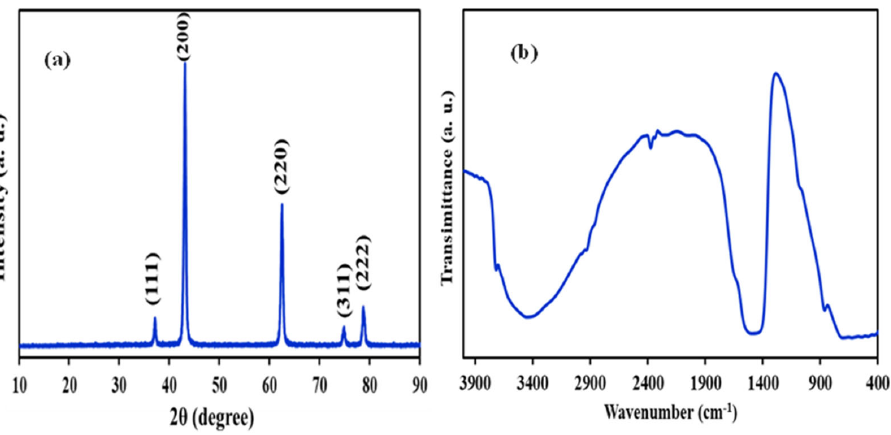
Figure 1. ( a ) XRD patterns, and ( b ) FTIR spectrum of MgO